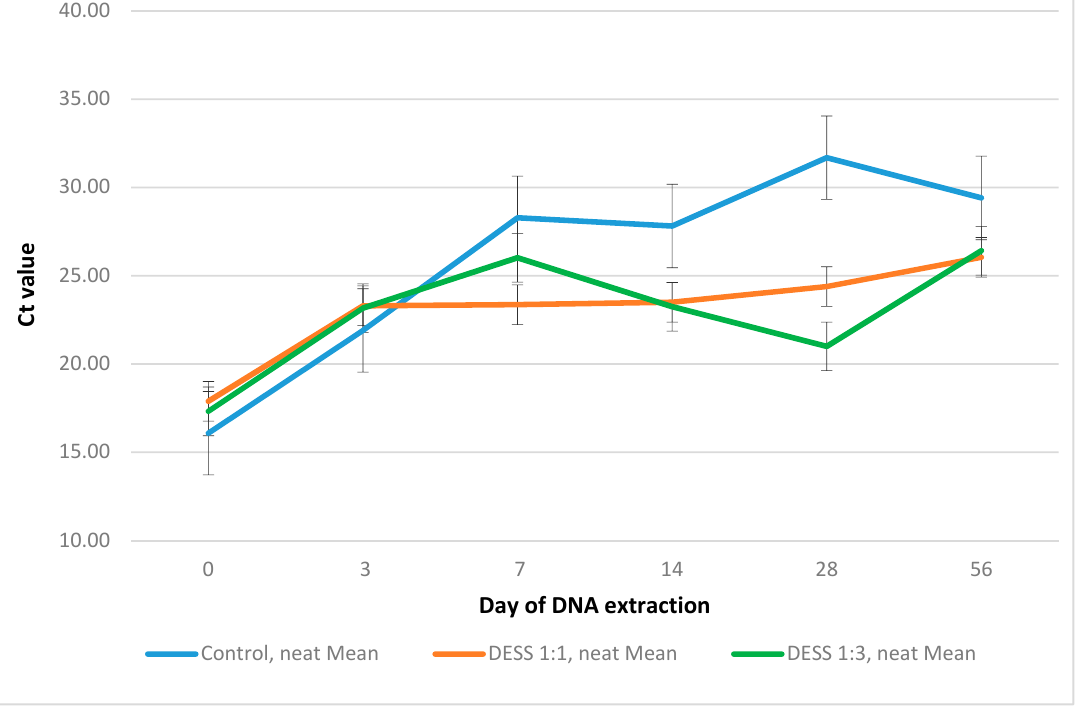
Figure 1. Performance of 1:1 and 1:3 ratios of Strongyloides ratti spiked fecal sample to DESS (dimethyl sulfoxide, disodium EDTA, and saturated NaCl) and a no-treatment control over time.